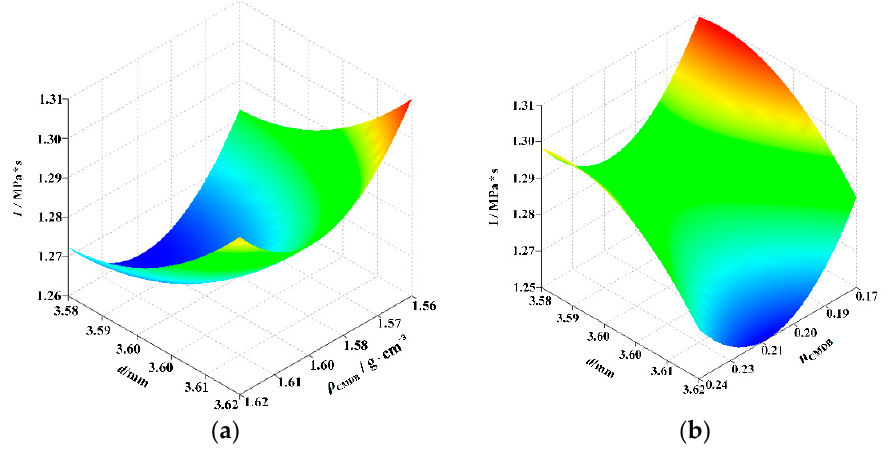
Figure 9. Response surface of the Kriging model. ( a ) I ~( d , ρ CMDB ), ( b ) I ~( d , n CMDB ).